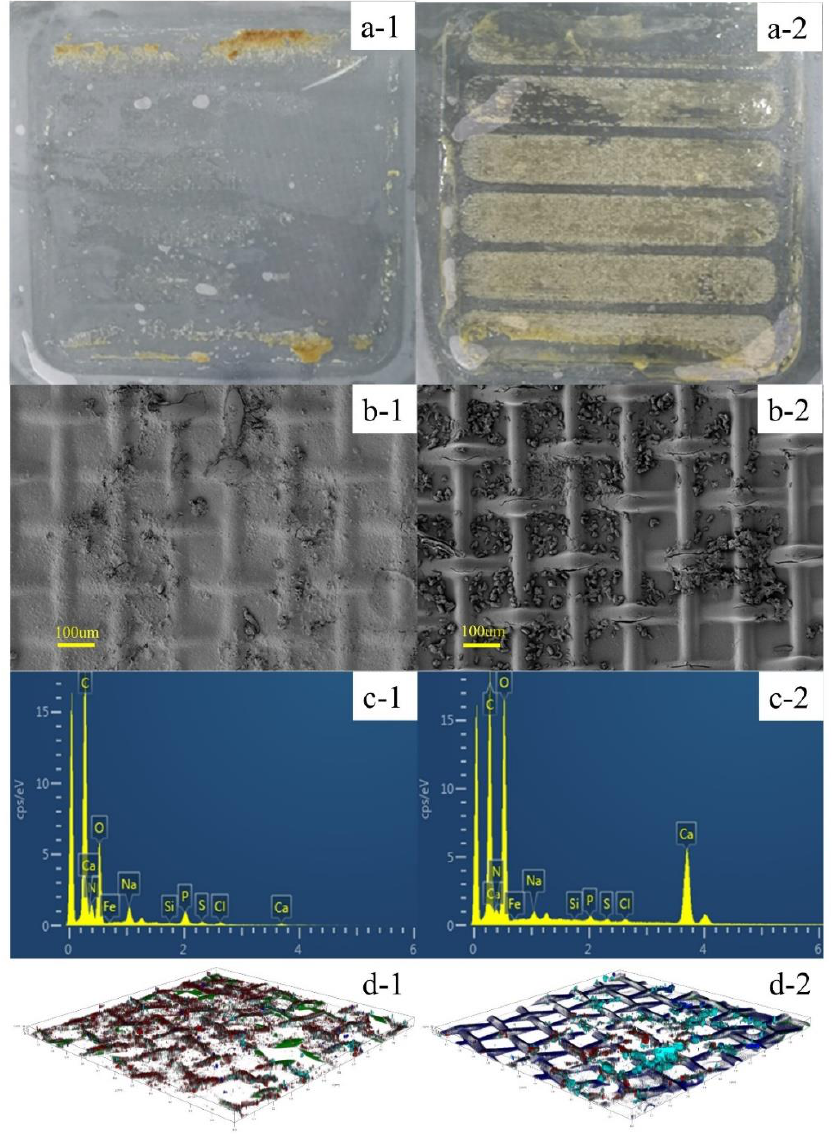
Figure 4. ( a ) The original picture of fouled membrane surfaces; ( b ) SEM and ( c ) EDX image of membrane surfaces after the PRO-MBR operation; ( d ) CLSM images of fouled membrane after the PRO-MBR operation in the (1) AL-FS and (2) AL-DS modes. The fluorescence colors of α -D- glucopyranose polysaccharides, β -D-glucopyranose polysaccharides, proteins and microorganisms were cyan, blue, green and red in CLSM images, respectively. (For interpretation of the references to color in this figure legend, the reader is referred to the web version of this